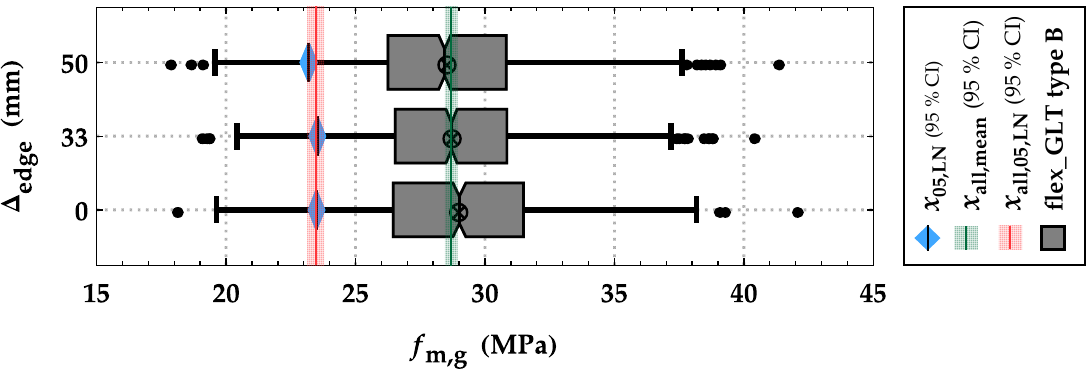
Figure 27. Boxplots together with mean and 5%-quantile values of the bending strength f m,g of flex_GLT type B beams with dimension h g = 360 mm and w g = 150 mm featuring different overlaps of Δ edge = {0; 33; 50} mm = {0; 1/3; 1/2} × w b between the board edges of the neighbouring layers built up from boards of group GI (T14) with dimensions of w b = 100 mm and t b = 30 mm.